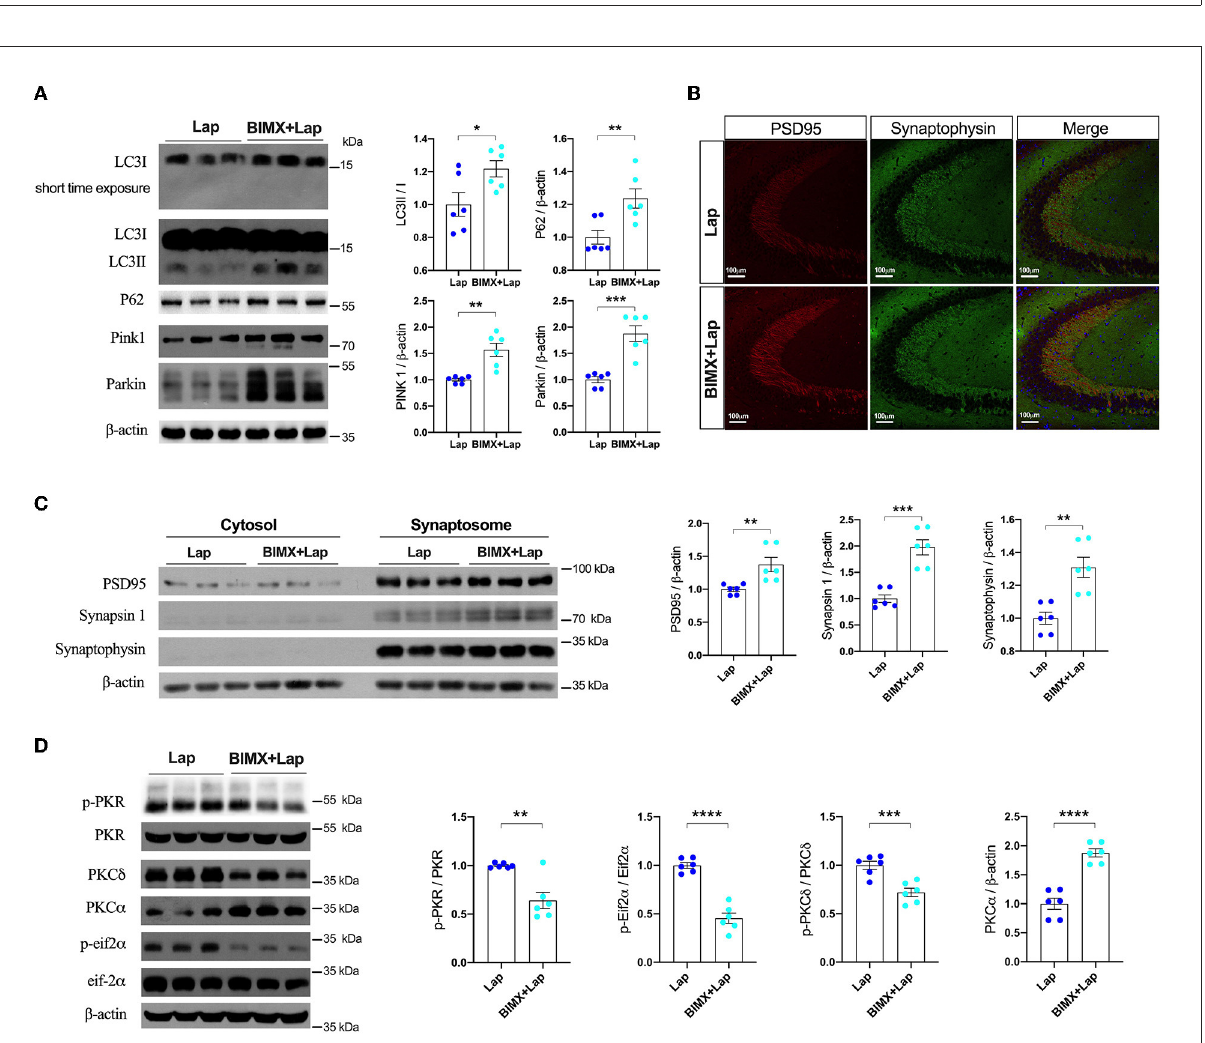
FIGURE6 Inhibition of PKC attenuated deficits of autophagy and synapse in middle-aged wild-type mice. (A) Autophagy protein expressions without or with PKC inhibitor (BIMX) following laparotomy in the wild-type mice. (B) Spread of synaptic proteins, including PSD95 and synaptophysin, was observed using immunofluorescent staining in the cornu ammonis (CA) 3 hippocampal region after laparotomy. (C) Synaptic protein expressions in the cytosol and synaptosome in postoperative hippocampi without or with BIMX using Western blot analysis. (D) Activities of PKR with pharmacological inhibition of PKC in middle-aged wild-type mice after laparotomy. Wt, wild type; Ctrl, control; Lap, laparotomy. Data are presented as mean ± SEM and were analyzed using one-way ANOVA using Tukey’s post hoc test, * P < 0.05, ** P < 0.01, *** P < 0.001, **** P <